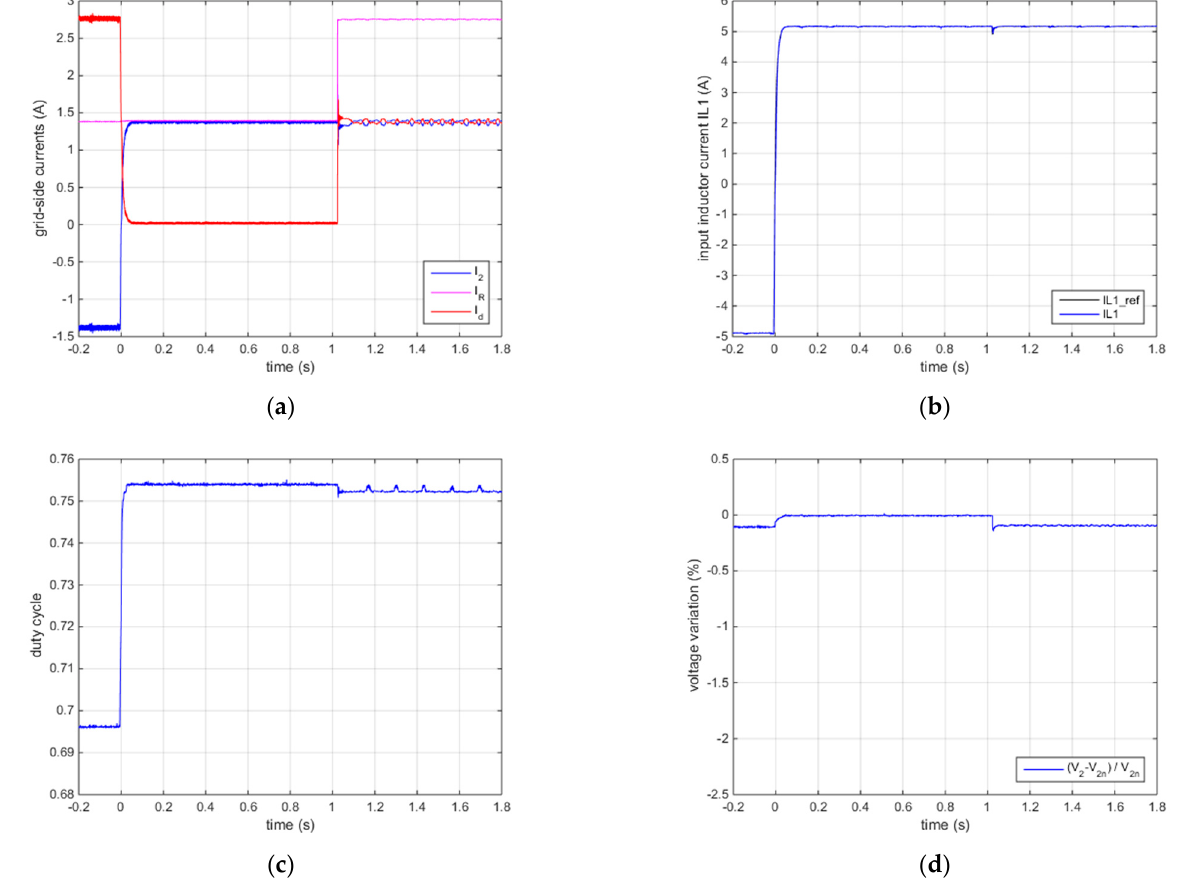
Figure 14. Experimental results in scenario #5 (SC − GS): ( a ) grid − side currents; ( b ) input inductor current; ( c ) duty cycle; ( d ) percentage variation of microgrid voltage.